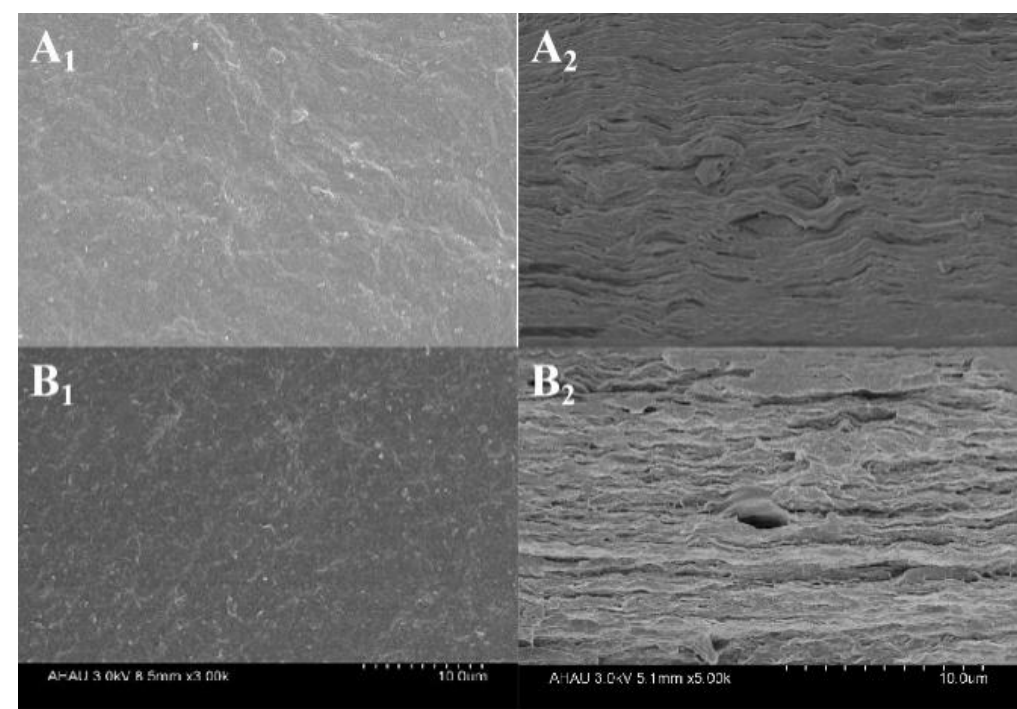
Figure 2. SEM images of the surface ( A 1 , B 1 ) and cross section ( A 2 , B 2 ) of the composite films.